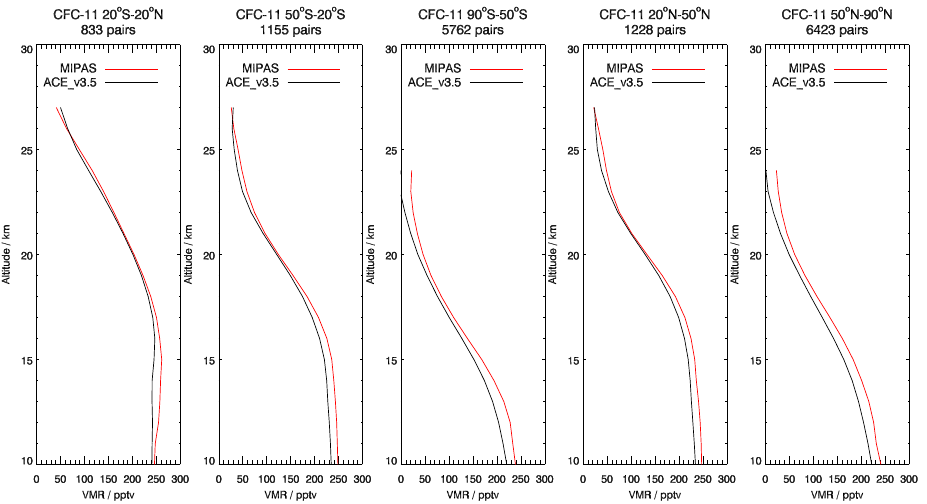
Figure A2. Comparison of mean profiles of MIPAS CFC-11 (red line) and ACE-FTS (black line) for different latitude bins for the years of